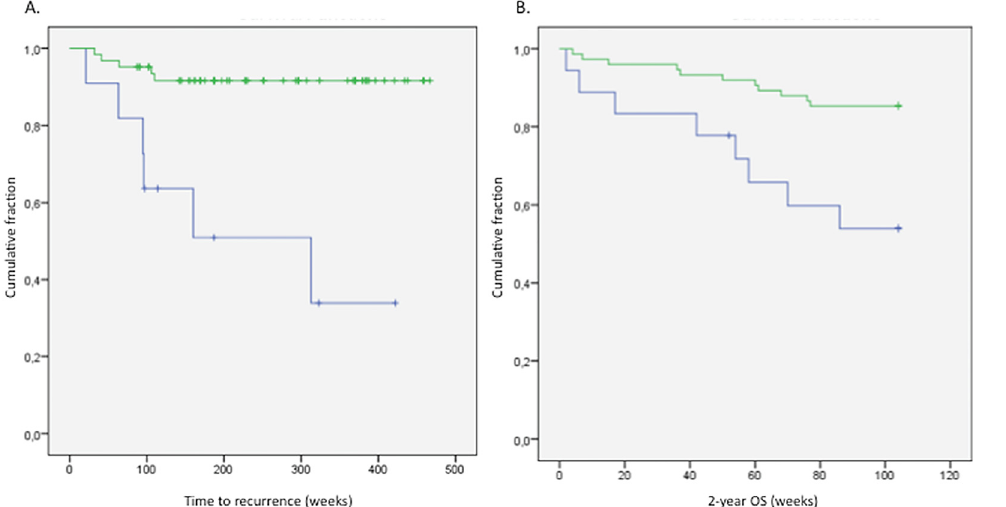
Fig 3. Kaplan Meier survival curves represented a worse prognosis for patients with loss of chromosome 4. Loss of chromosome 4 is linked with a shorter RFS, *** P < 0,001 (A) and a smaller 2-year OS, ** P = 0,002 (B). Patients without an alteration of chromosome 4 are presented in green, those with loss of chromosome 4 in